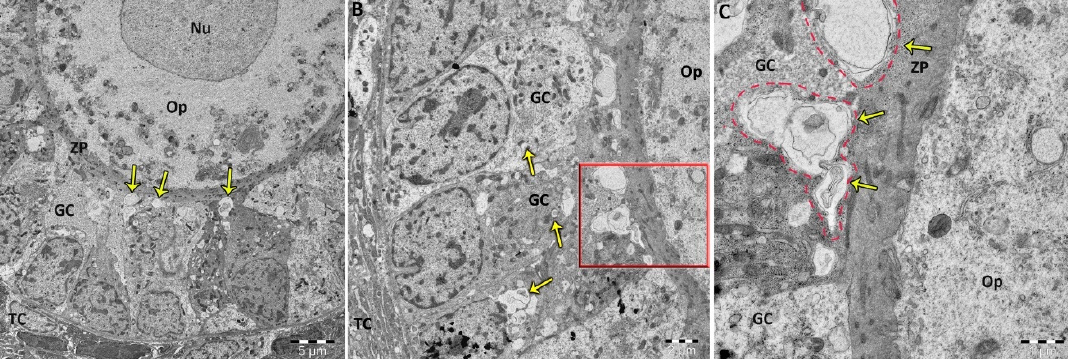
Figure 4. Transmission electron micrographs revealed significant increases in the numbers of au- tophagic vacuoles (arrows) in granulosa cells from females treated with low ( A ) and high doses of allethrin ( B , C ). Autophagic vacuoles are double-membrane structures that contain a number of atypical and/or injured mitochondria, endoplasmic reticulum membranes and cytoplasm ( C ). How- ever, these autophagosomes were not detected in oocytes or theca cells. GC: granulosa cell, Nu: